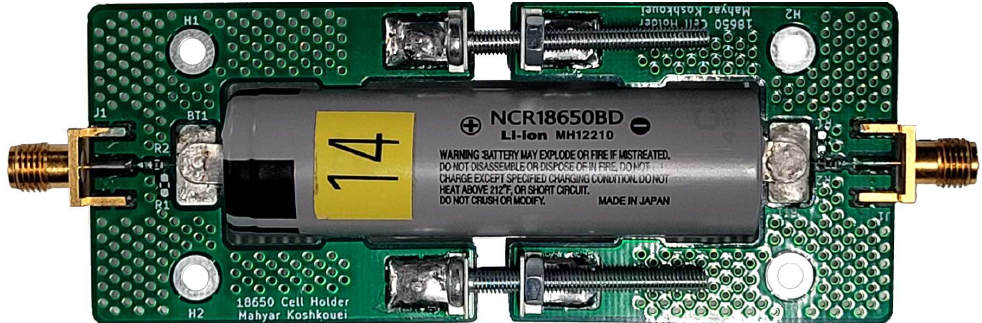
Figure 6. Photo of the Li-ion cell clamped within the cell